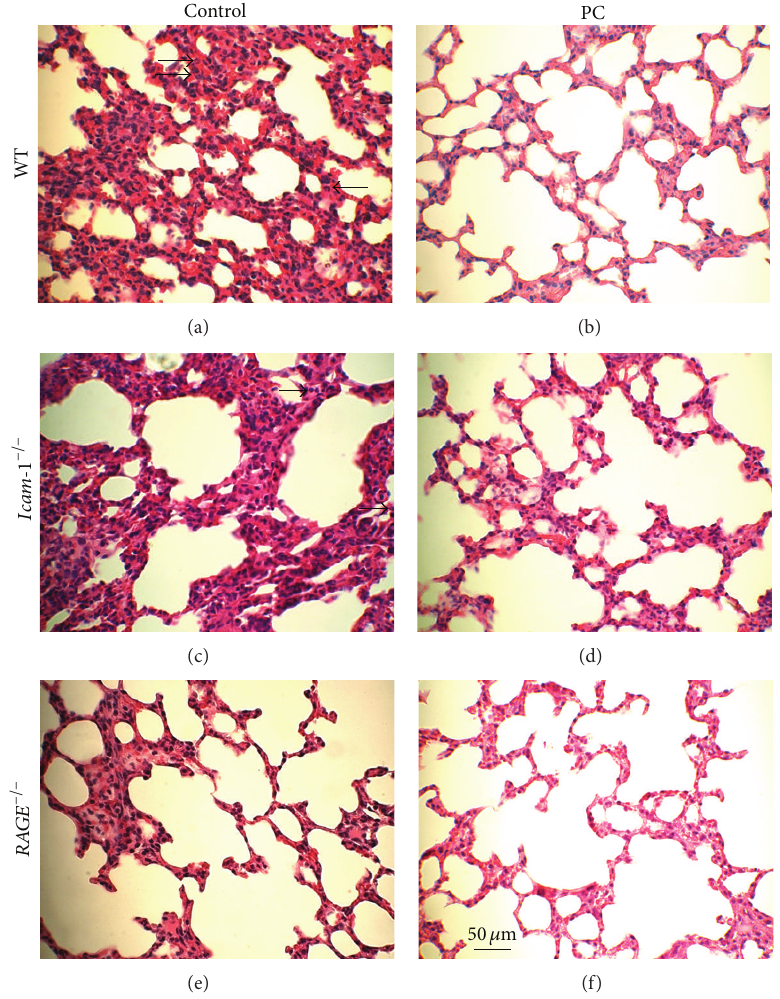
Figure 6: Effect of PC treatment on lung inflammation during LPS-induced endotoxemia in wild-type, RAGE −/− , and Icam-1 −/− mice. Lethal endotoxemia was induced by Escherichia coli LPS (serotype 055:B5, 40mg/kg i.p.) and treated with PC (100U/kg, i.p.) or human albumin (8mg/mL) as controls at 0.5, 8, and 24 h after LPS challenge. Lungs of WT mice (a and b), Icam-1 −/− mice (c and d), and RAGE −/− mice (e and f) with and without PC treatment were harvested 24 h after LPS challenge and prepared as 3 𝜇 m paraffin-embedded sections for H&E staining. Representative micrographs are shown for at least three mice per group. Arrows indicate infiltrating neutrophils. Reference bar for (a)–(f) is shown in (a) and represents 50 𝜇